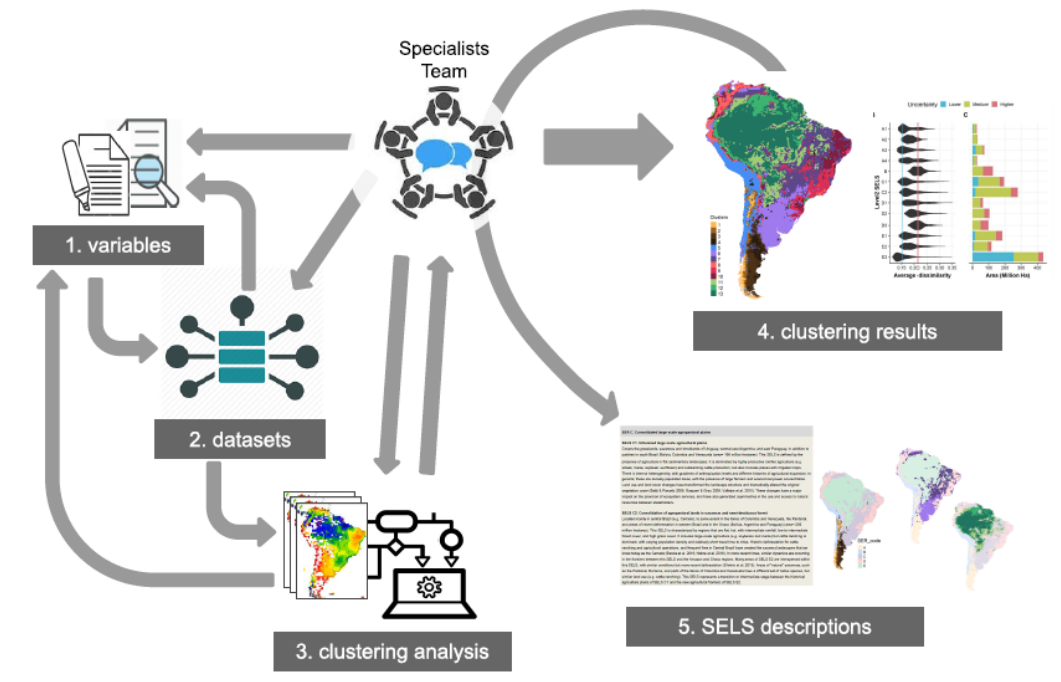
Figure A1.1 . Diagram of the methodological steps followed by this study. (1) Variables: analyze and systematize the conceptual SELS descriptions in Table 1 of Boillat et al. (2017) defining a list of variables to use as inputs for the clustering. (2) Datasets: search and retrieve the spatial data to best represent the selected variables. (3) Clustering analysis: generate automated classifications through hierarchical cluster analysis. (4) Clustering results: analyze the clustering outputs and agree on the SELS representation according to the specialists group’s territorial knowledge. (5) SELS descriptions: arrange in subgroups of regional specialists to discuss and describe each particular SELS. Arrows pointing backwards in relation to the numerical steps represent the feedback loops and local iterations of our